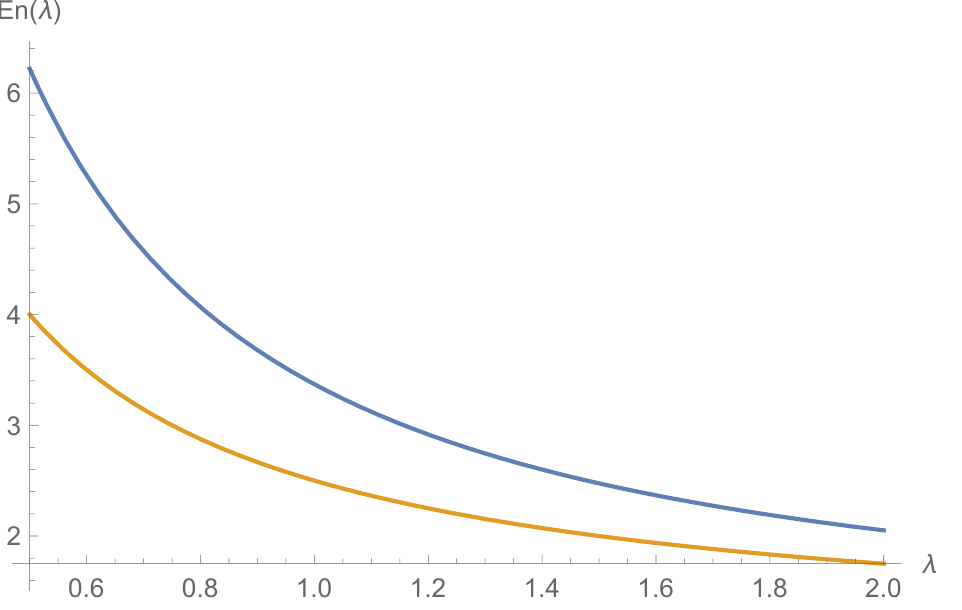
Figure 15. Average energy for free Lorentzian subluminal particles with low λ . The blue line depicts the correct value, while the orange line depicts the Maxwell–Boltzmann